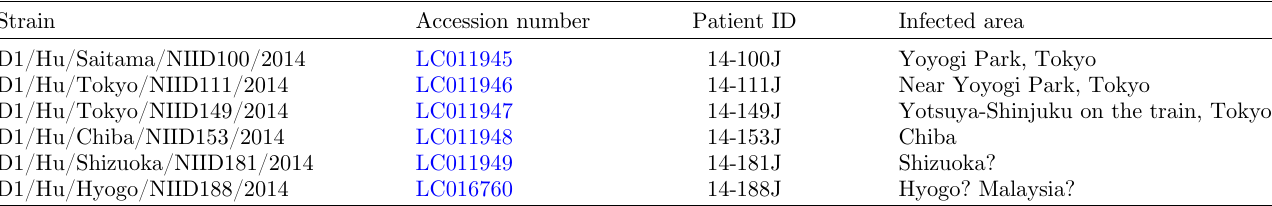
Table 1. Complete Sequences of Dengue Virus Type 1. Columns from left to right: (1) the identi fi cation of the sequence/strain, (2) the number of access to the NCBI base, (3) the patient from which it is coming the sequence, (4) the possible local of contamination of the